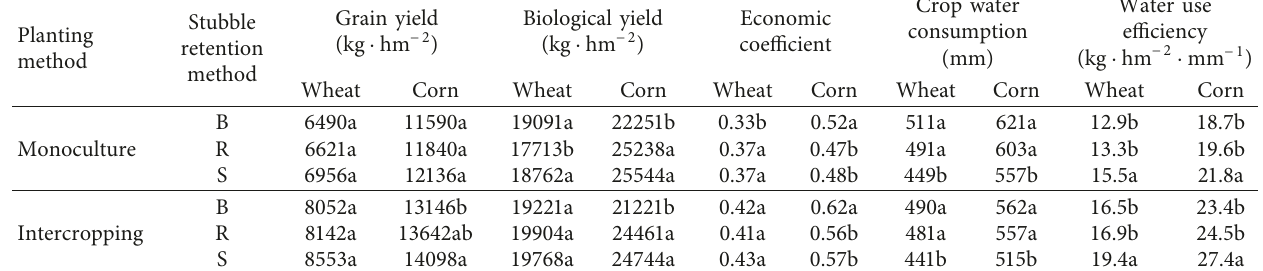
Table 5: Effects of stubble retention and planting patterns on crop yield and water use efficiency. Planting